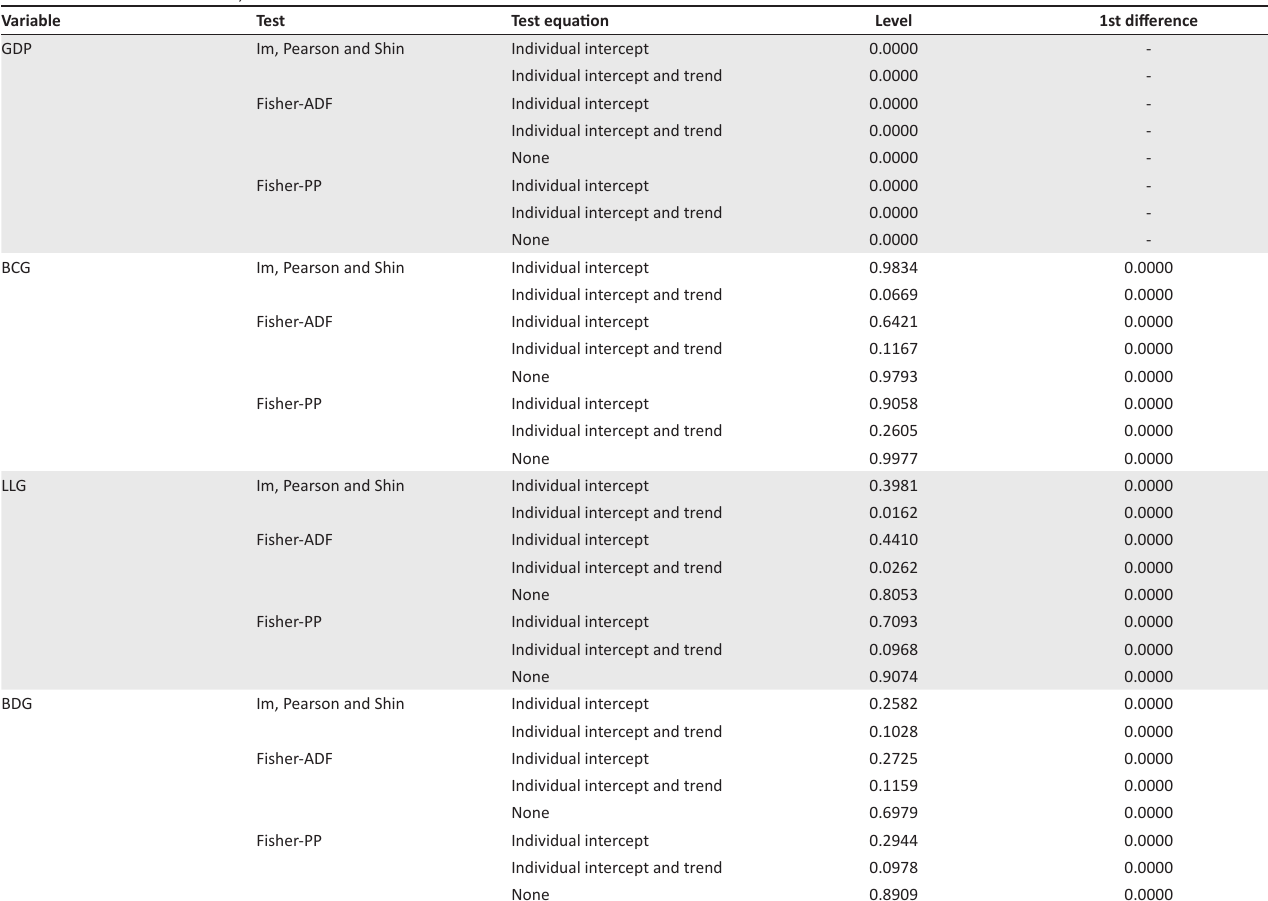
TABLE 1: Panel unit root results,